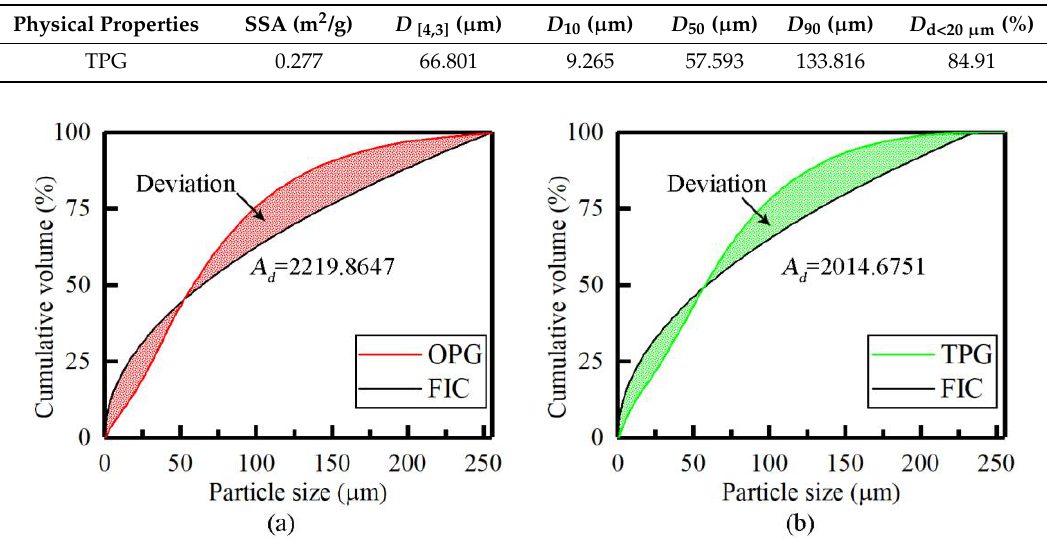
Table 6. Particle size characters of TPG.